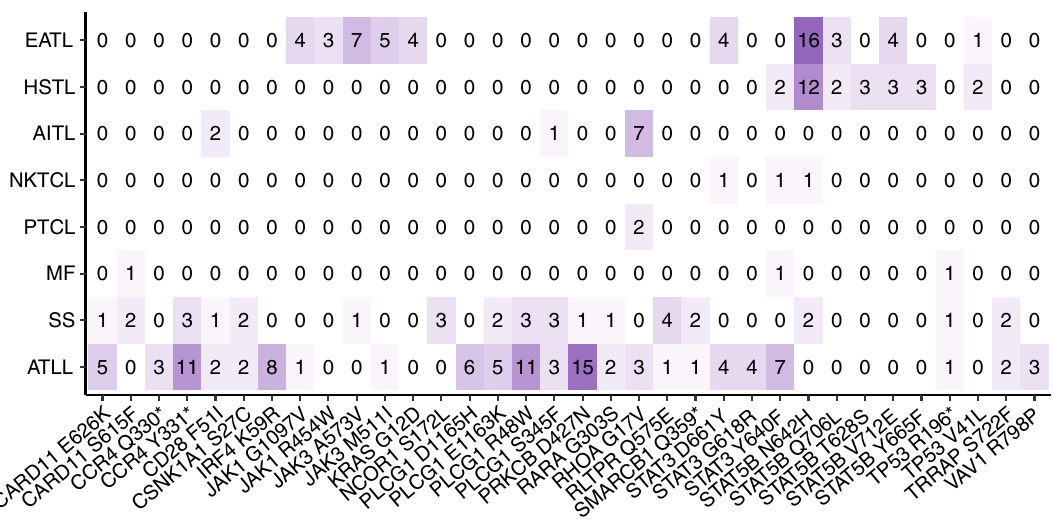
Figure 3. Recurrent driver gene mutations in mature T-cell NHL. Heatmap showing the number of patients with a given driver gene mutation for each subtype where a given variant occurred in three or more